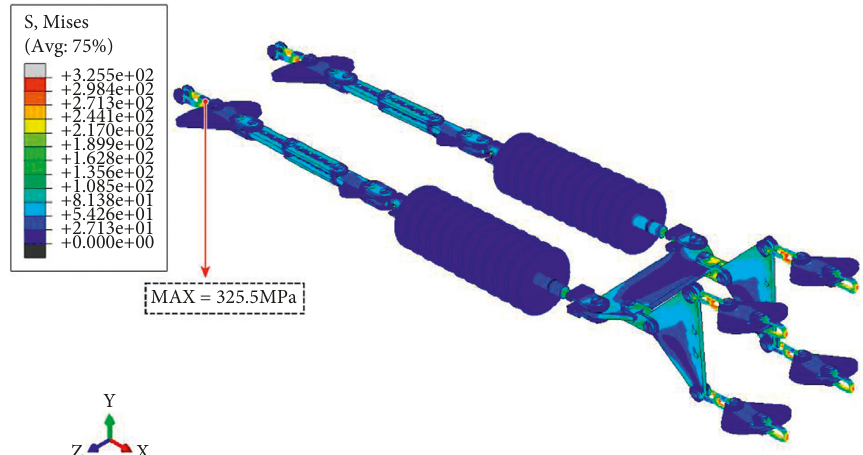
Figure 28: Stress cloud picture of tension